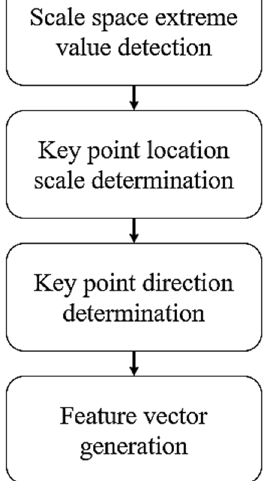
Figure 5. SIFT feature vector generation steps.